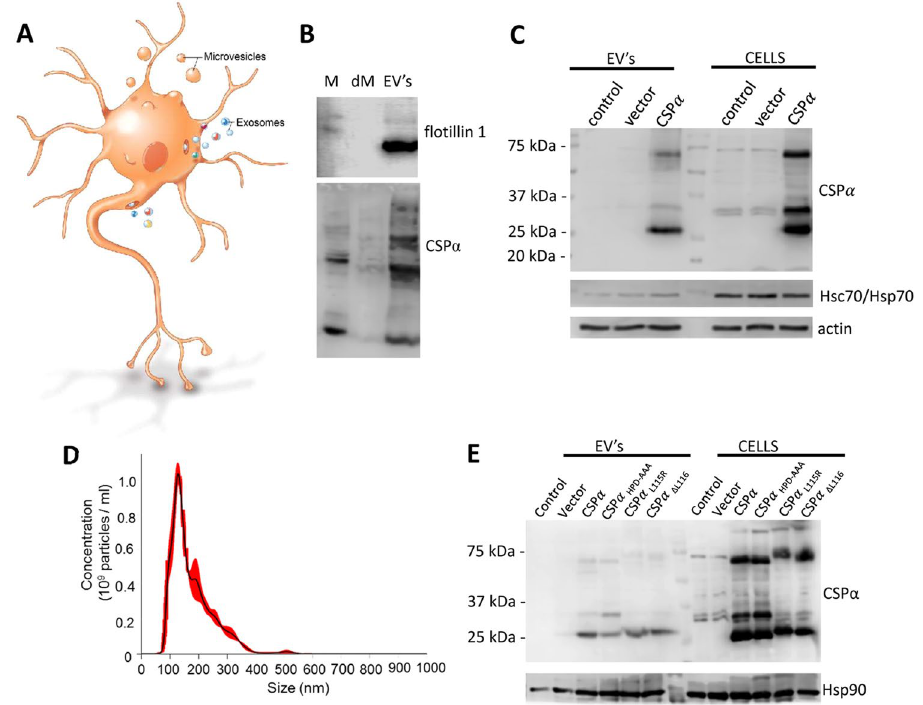
Figure 2. CSP α is released via EV’s. ( A ) Working model of extracellular vesicle release from neurons; illustration by Roula Drossis. Neural export of larger microvesicles and smaller exosomes are shown. ( B ) Immunoblot of media (M), media depleted of EV’s (dM) and the EV’s enriched for exosomes from CSP α transfected CAD cells. ( C ) Immunoblot of EV’s and corresponding cell lysates. ( D ) Size distribution of EV’s isolated from CSP α -transfected CAD cells. Red error bars indicate + / − 1 standard error of the mean. ( E ) Immunoblot of EV’s and CAD cell lysates (15 µ g) collected 48 hrs after transfection of 3.7 μ g of vector,